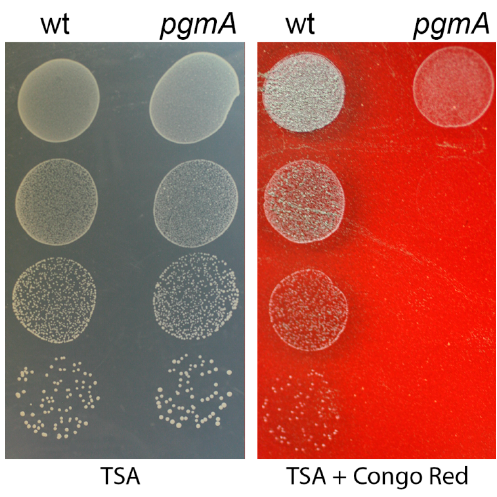
Figure 4. Phase contrast microphotographs (1000 times magnification) of the S. mutans UA159 wild type ( A ) and pgmA mutant ( B ) from planktonic cultures. Airyscan images of the wild type ( C ) and pgmA mutant ( D ) grown as biofilms on submerged glass surfaces. Bars correspond to 4 µ m. Reduced cell wall integrity has been shown to correlate with increased sensitivity to the dye Congo Red [33]. To investigate the relative cell wall integrity of the S. mutans wild type and pgmA mutant, we assayed the sensitivity toward Congo Red. Serial dilutions of the strains were spotted on TSA plates with and without Congo Red. The wild-type strain was not inhibited in colony formation on agar plates with Congo Red, while the pgmA mutant showed a marked sensitivity toward Congo Red (Figure 5).